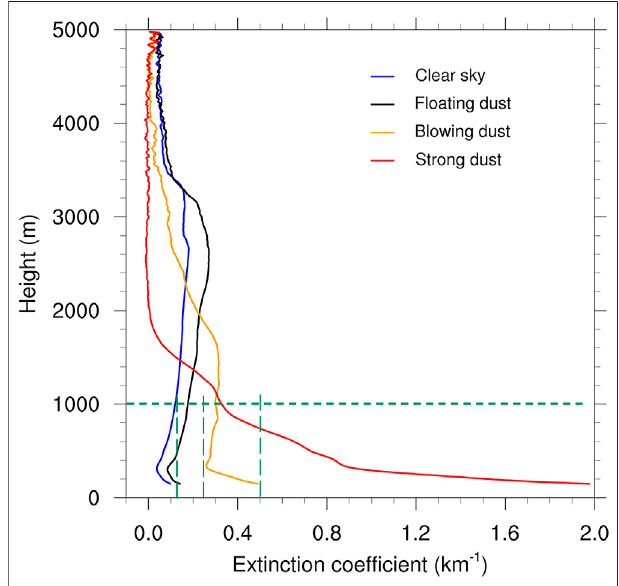
FIGURE 10 | Averaged vertical pro fi les of aerosol extinction coef fi cient (km − 1 ) at Tazhong under clear sky (blue), fl oating dust (black), blowing dust (orange), and strong dust storm (red) conditions. The clear-sky days were from September 21 to 29, 2019. The fl oating dusty days were July 27 and 29, August 12 and 13, and September13, 2019. The blowing dusty days include July 26 and August 3 and 4, 2019. The strong dusty days include July 25, August 10, 11, and 17, and September 6 and 10, Figure 9 draws the vertical pro fi les of log 10 (RCS), surface wind speed, and VOR under different dust events at Tazhong. Here the clear-sky days, fl oating dust, blowing dust, and strong dust storms are from September 21 and 22, August 12 and 13, August 3 and 4, July 25, and August 10, 2019, respectively. The backscattering signal intensities log 10 (RCS) and VORs of the ceilometer present pronounced diurnal variations with the increase of surface wind speed and persistence of high wind speed. The maximal AMLH values are about 4.0, 3.2, 2.5, and 1.0 km for clear-sky days, fl oating dust, blowing dust, and heavy dust storms, respectively, which is majorly owing to the different concentrations of dust particles produced from the surface and caused by different degrees of attenuation of emitted laser pulse energy. The log 10 (RCS) under clear-sky conditions are all lower than 5.2 and range from 5.2 to 5.8 under fl oating dust and from 5.6 to 6.2 under blowing dust. The log 10 (RCS) are higher than 6.2 for heavy dust storm cases. Affected by the lofted dust particles, the atmospheric turbidities signi fi cantly increase, and the corresponding VOR values vary from 3.2 to 4.0 km, from 2.0 to 3.5 km, from 1.5 to 3.0 km, and from 0.2 to 1.5 km, respectively. Obviously, the diurnal variations of VOR greatly fl uctuate under strong dust storms and blowing dust. In comparison, the clear-sky VORs display relatively smooth variations. The overall mean VOR values are approximately 3.37, 2.64, 1.92, and 0.32 km for four typical weather types, respectively, as shown in Figure 9 .